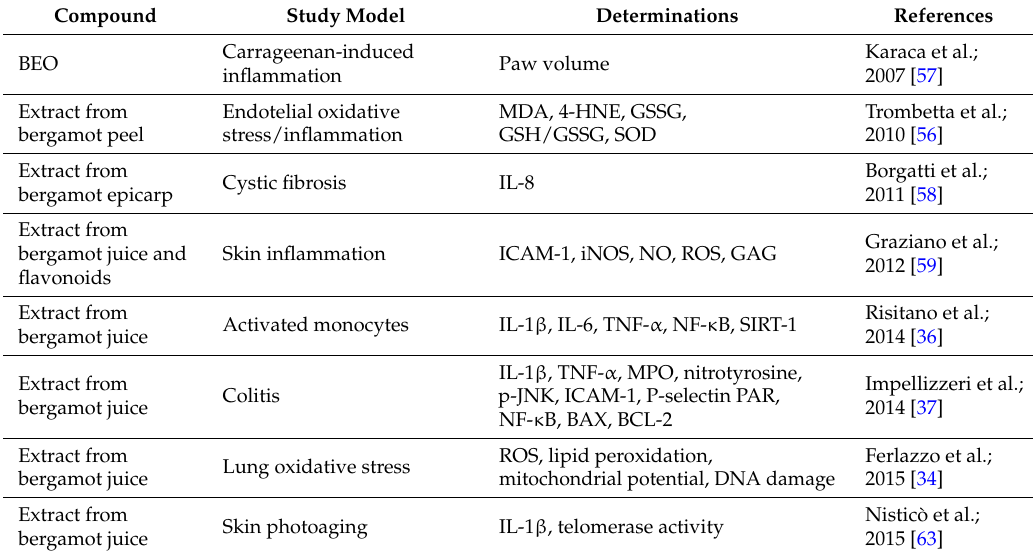
Table 3. Principal characteristics of studies on anti-inflammatory effect of bergamot